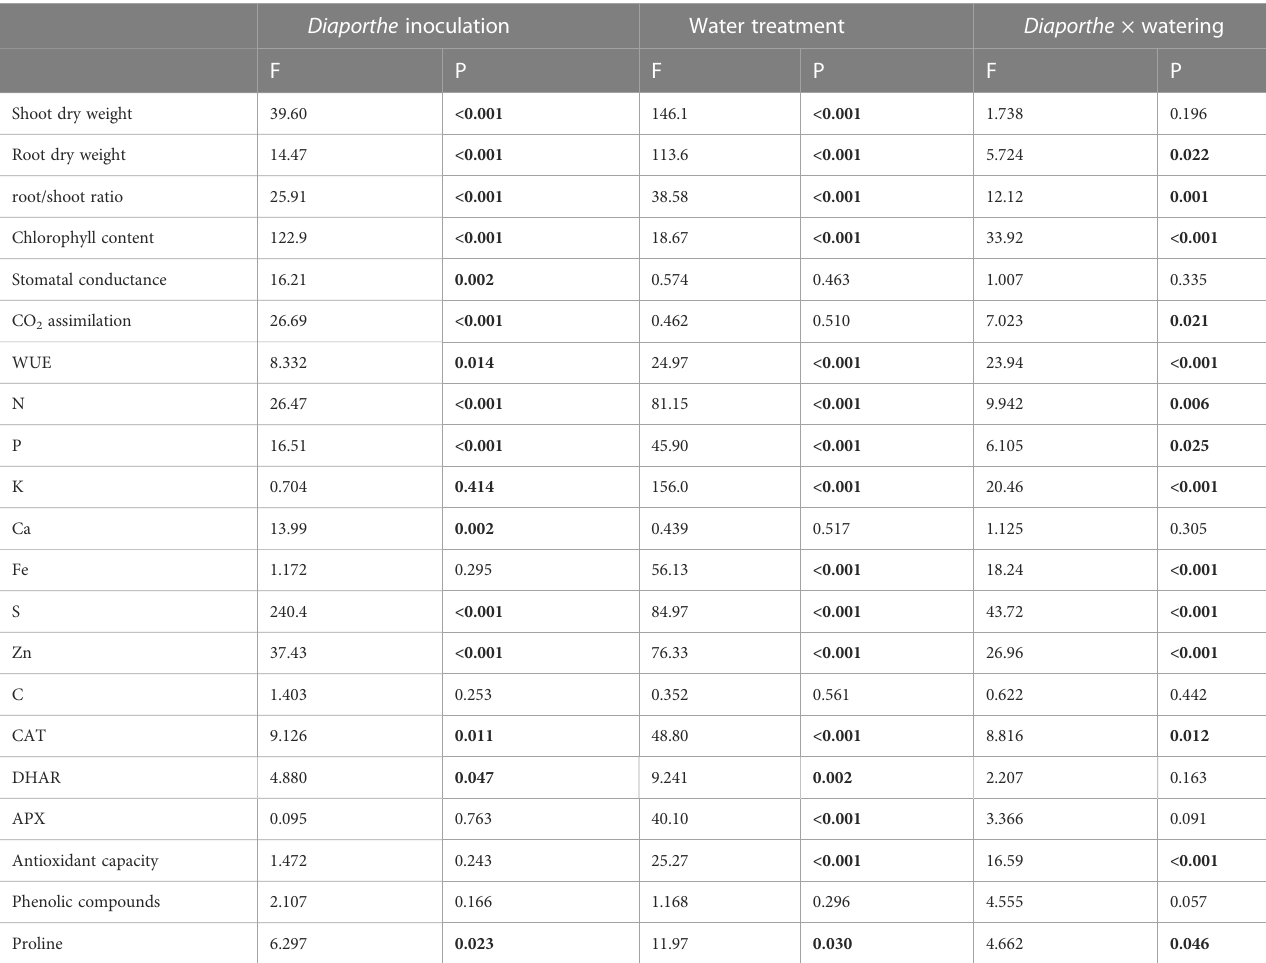
Numbers in bold indicate that the factor signi fi cantly affects the